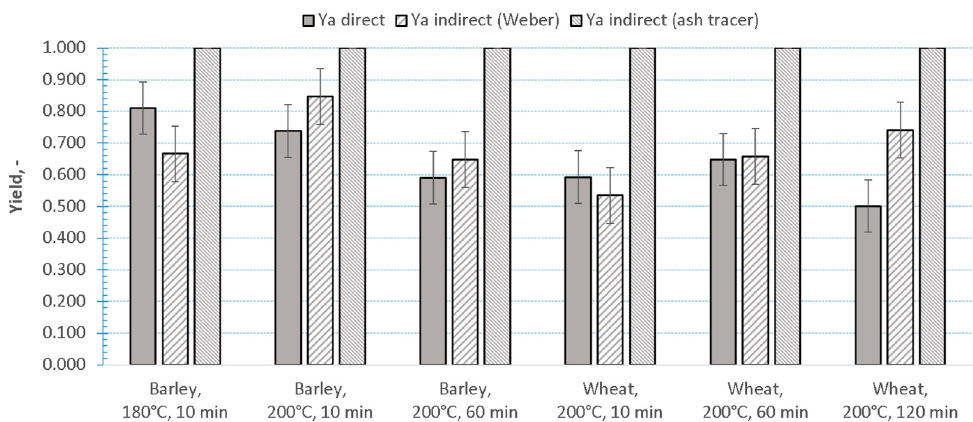
Figure 8. Comparison of ash yield, determined for hydrothermal carbonization experiments, by direct and indirect method.